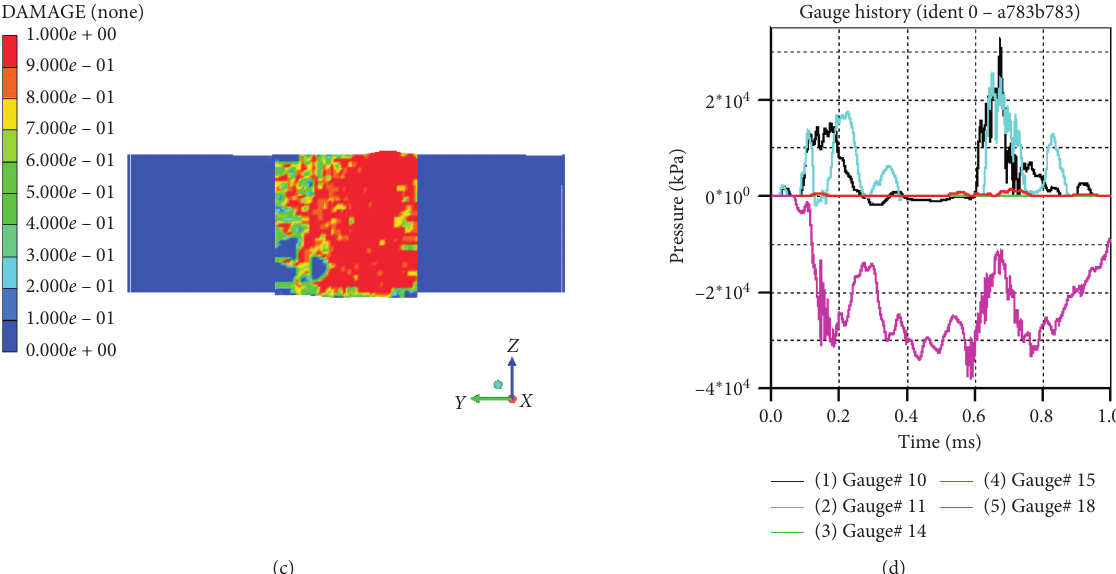
Figure 11: Target damage under configuration set 4 ( t � 1 ms): (a) front view, (b) section view by XZ plane, (c) section view by YZ plane, and (d) gauge